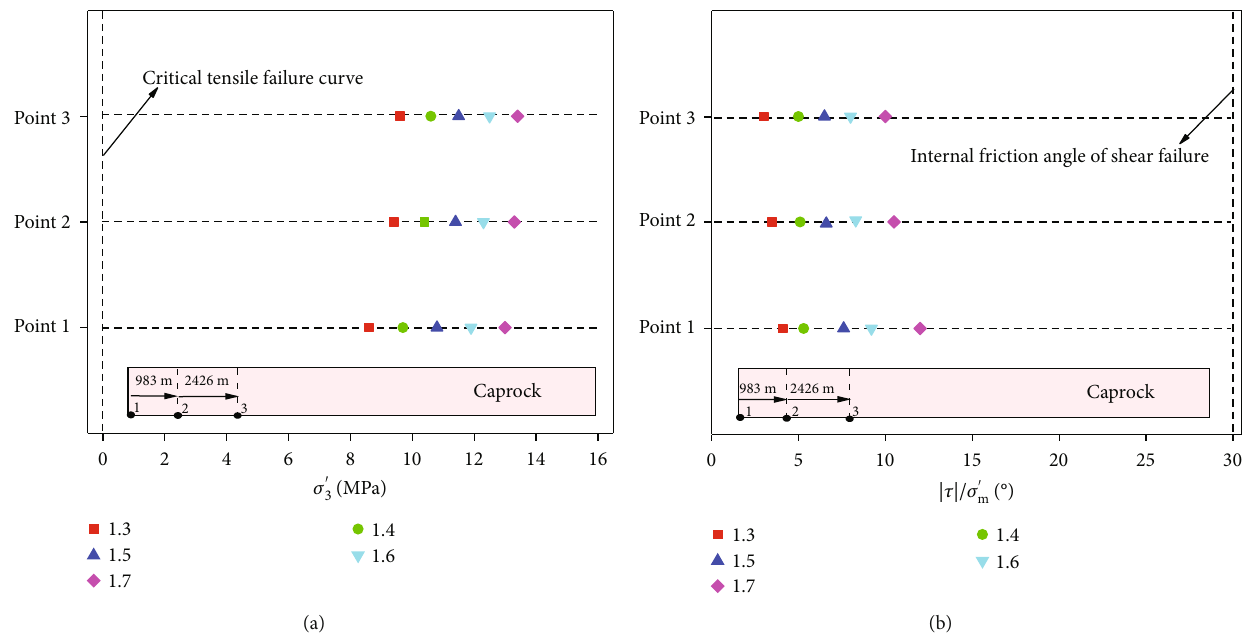
Figure 21: In fl uence of upper limit pressure coe ffi cient on mechanical integrity of caprock. (a) The minimum principal stress. (b) Critical internal friction